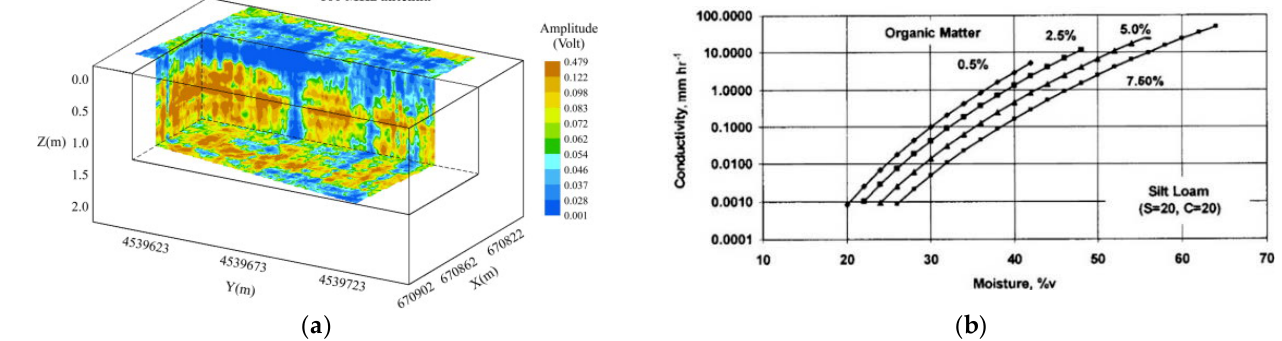
Figure 8. GPR prospecting for soil textural properties. ( a ) Prediction of clay content from analysis of GPR reflection data signal amplitude [236]. ( b ) Variations of soil hydraulic conductivity and moisture by organic matter [251].